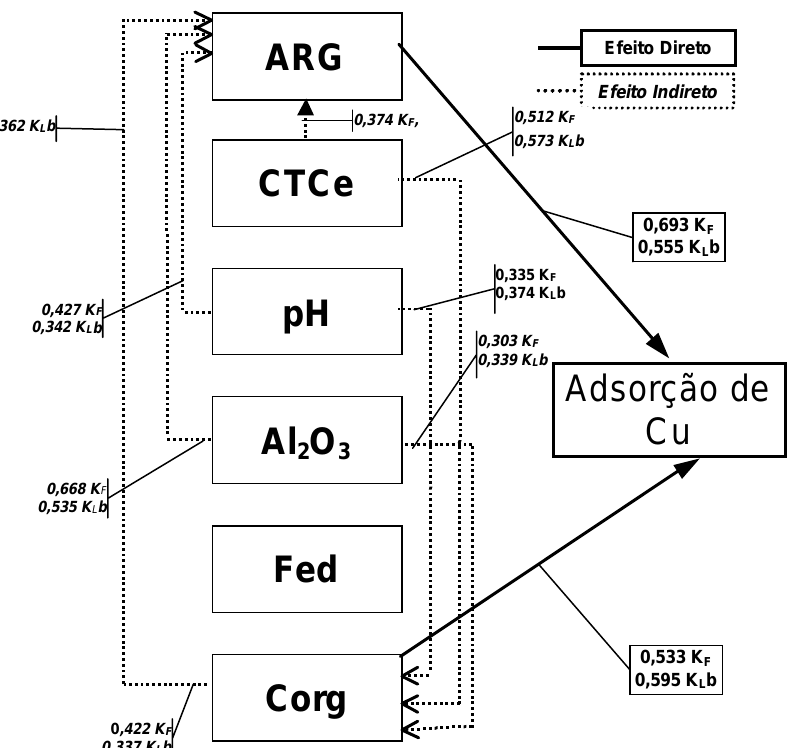
Figura 1. Diagrama explicativo com os valores dos efeitos diretos e indiretos obtidos da análise de trilha para as constantes Freundlich (K de Corg, CTCe, pH, ARG, Al